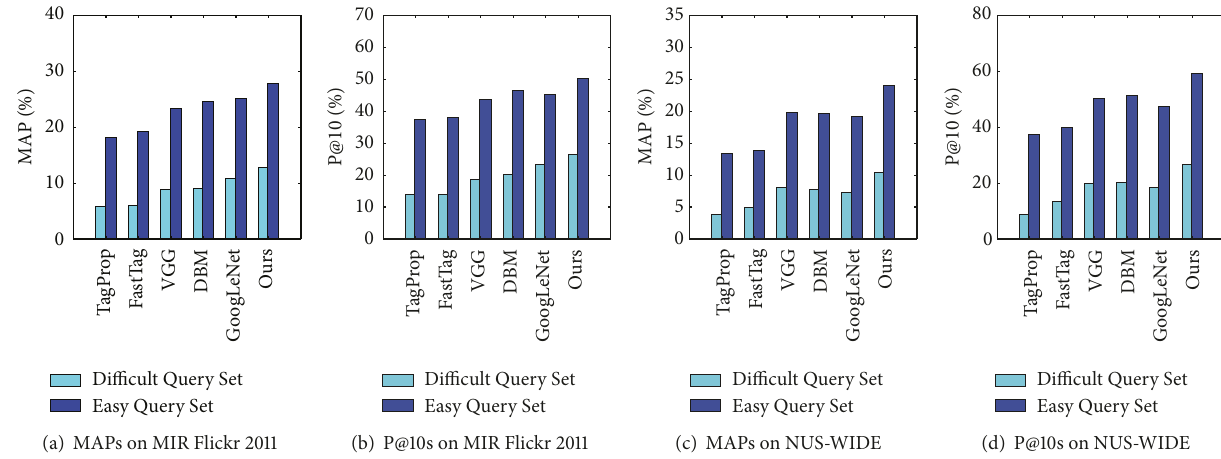
Figure 2: Semantic retrieval performance (MAPs % and P@10s %) over the comparative group: a difficult query set and an easy query set on two datasets.